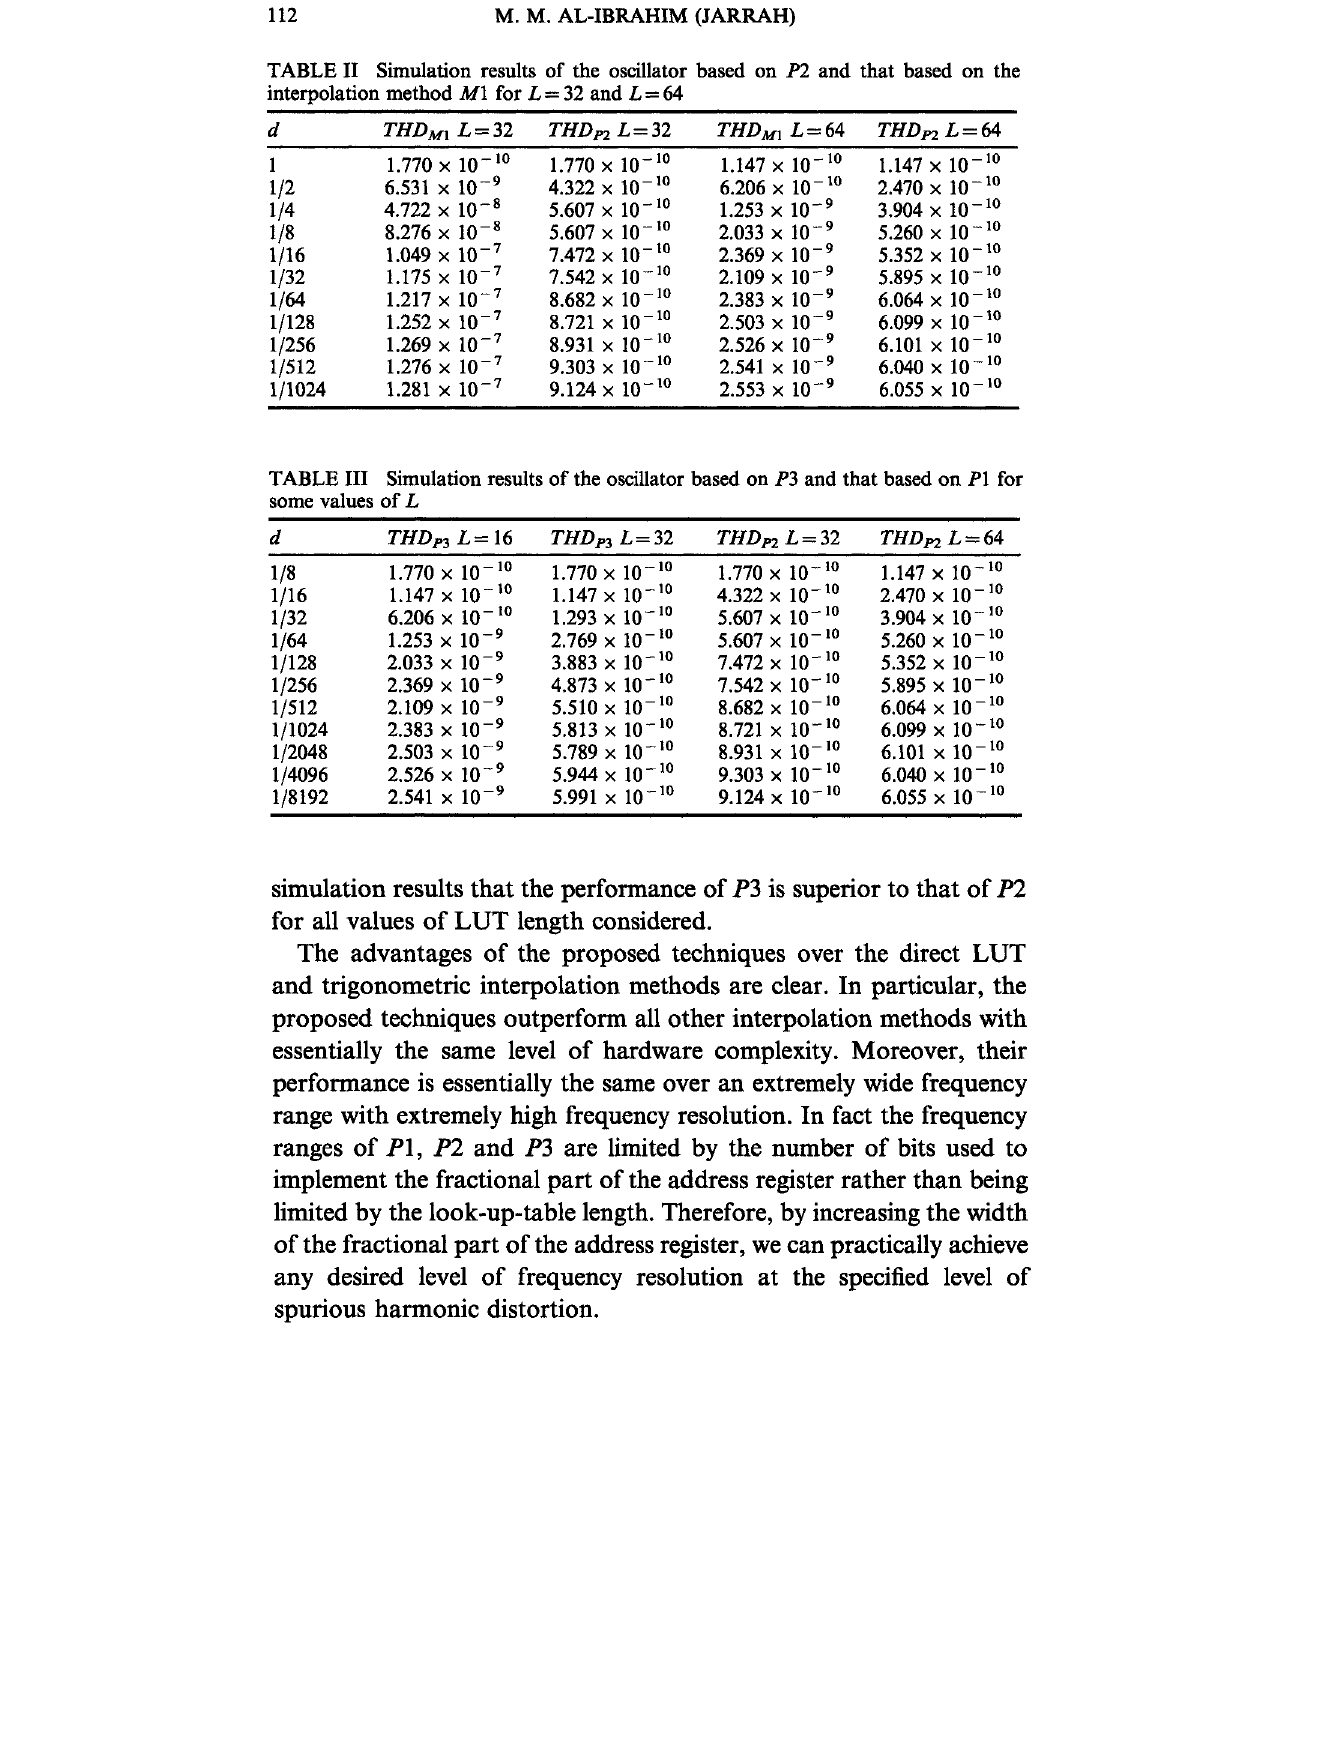
TABLE II Simulation results of the oscillator based on P2 and that based on the interpolation method M1 for L 32 and L 64 d